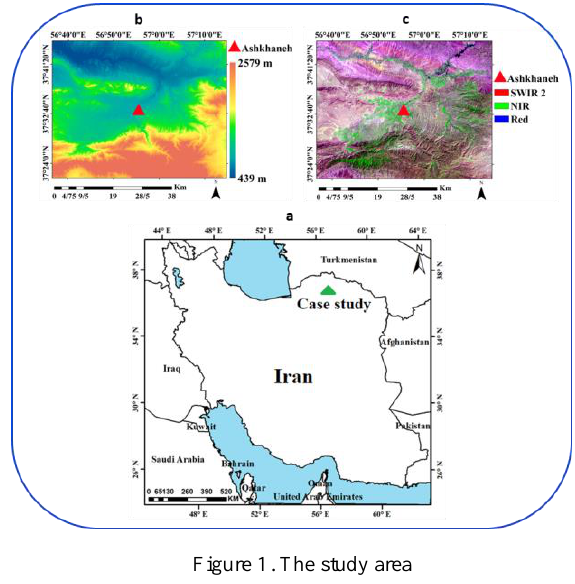
Figure 1. The study area